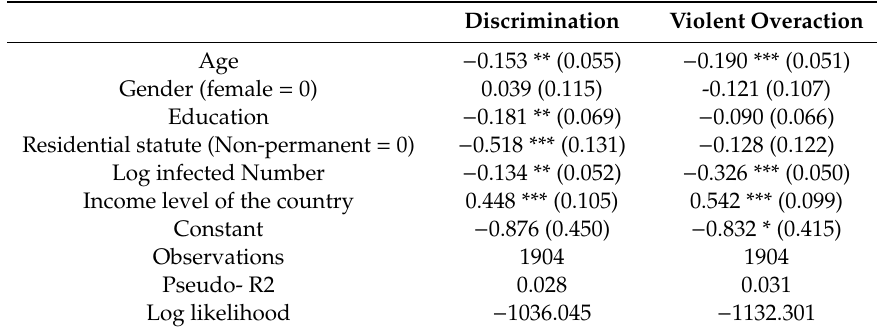
Table 1. Logit model of discrimination and overaction across the world.